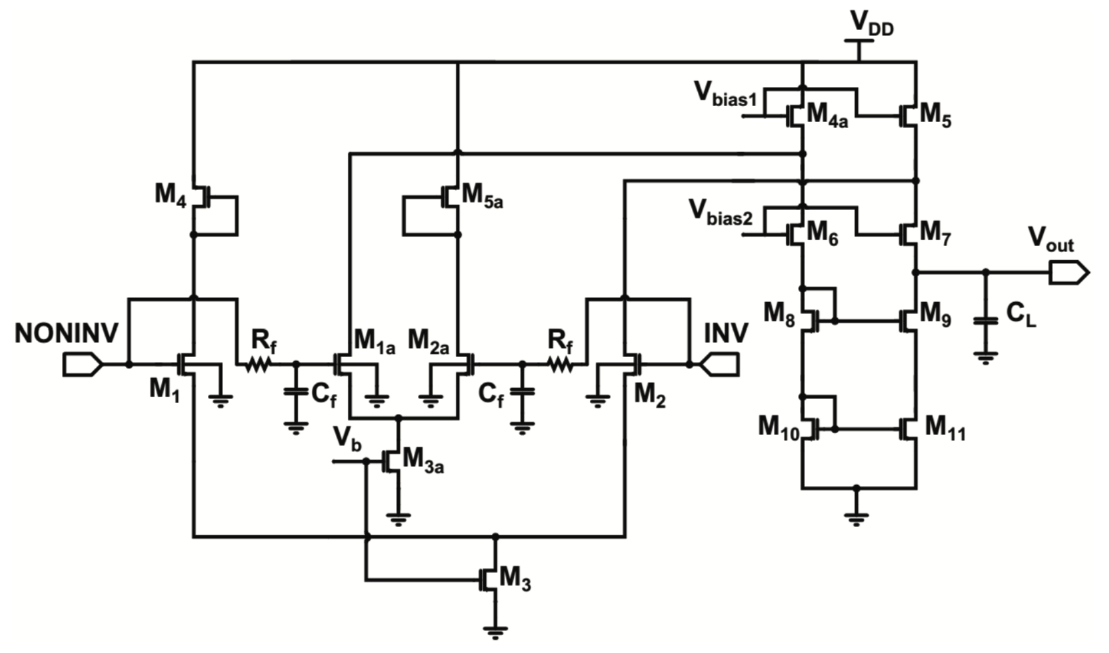
Figure 8. Folded cascode with replica circuit to filter